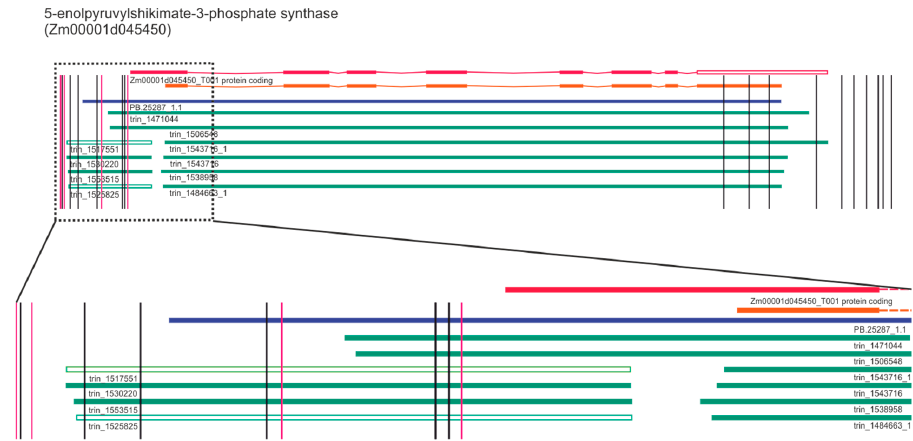
Figure 3. Location of identified SNPs (black) and indels (violet) on the 5-enolpyruvylshikimate-3-phosphate synthase (EPSPS) gene.